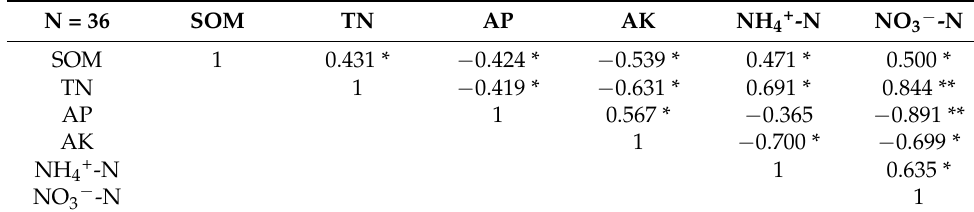
Table 3. Correlation analysis of soil chemical properties in Populus tomentosa stands under different nitrogen application rates and irrigation conditions. N = 36 SOM TN AP AK NH 4+ -N NO 3 − -N SOM